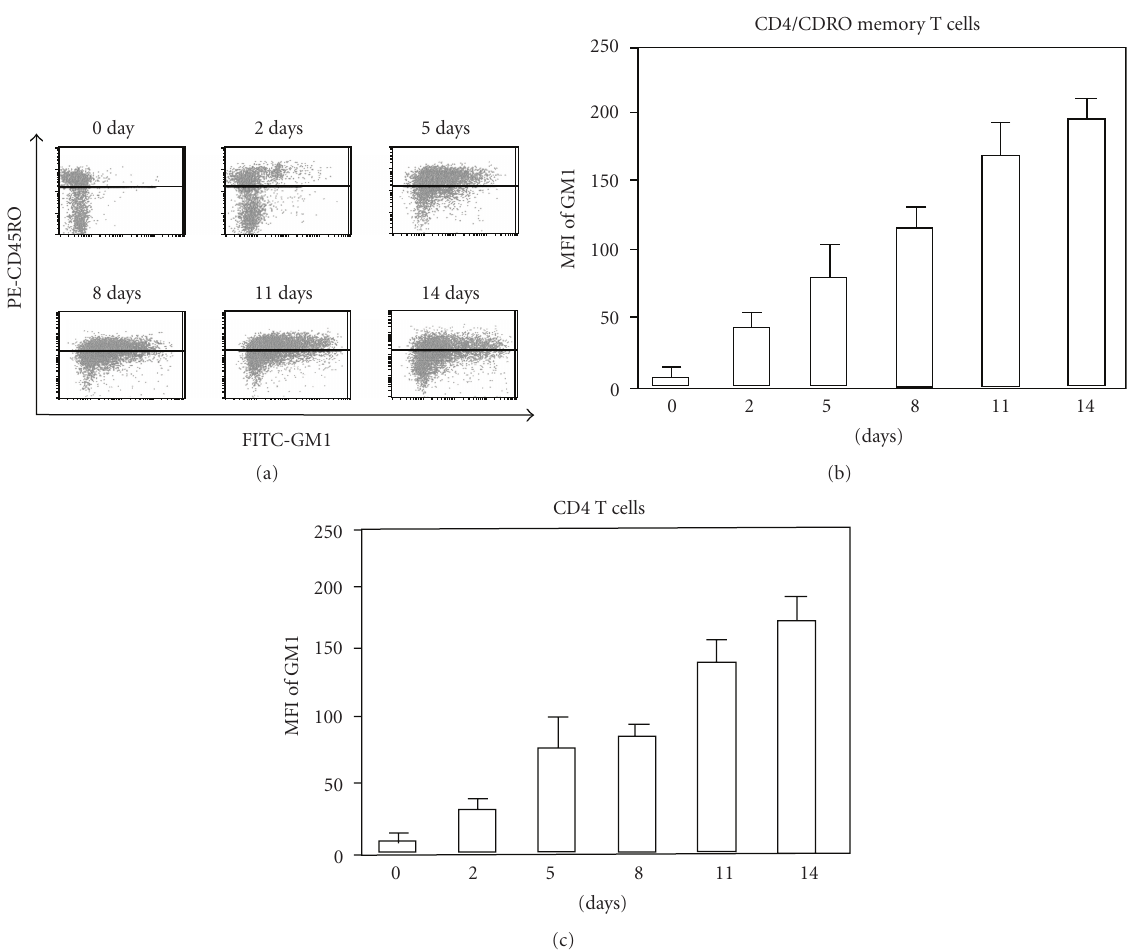
Figure 1: Time kinetics of GM1 expressions on PHA-activated T cells. Peripheral mononuclear cells were stimulated with 1 μ g/ml of PHA and maintained with IL-2-containing medium for two weeks. GM1 expression on memory T cells were detected with FITC-CTB and PE- CD45RO antibody on days 0, 2, 5, 8, 11 and 14 after stimulation (a). The mean fluorescence intensity (MFI) of GM1 were measured